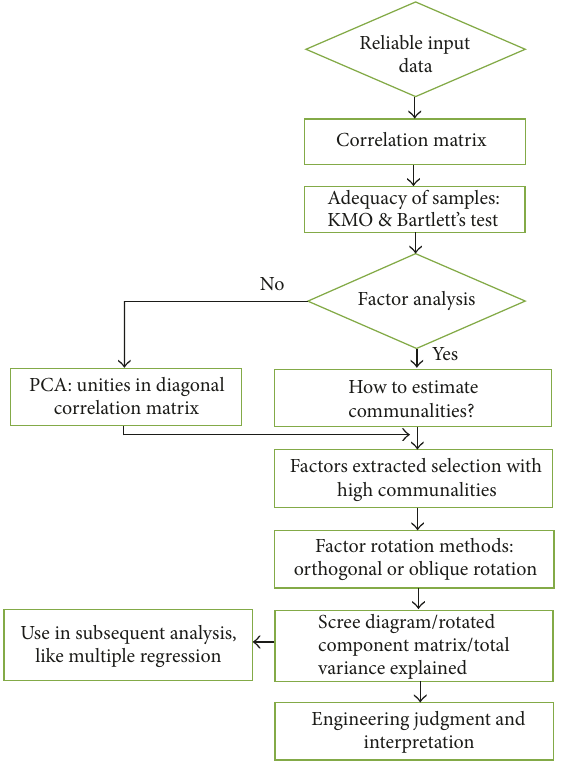
Figure 5: Factor